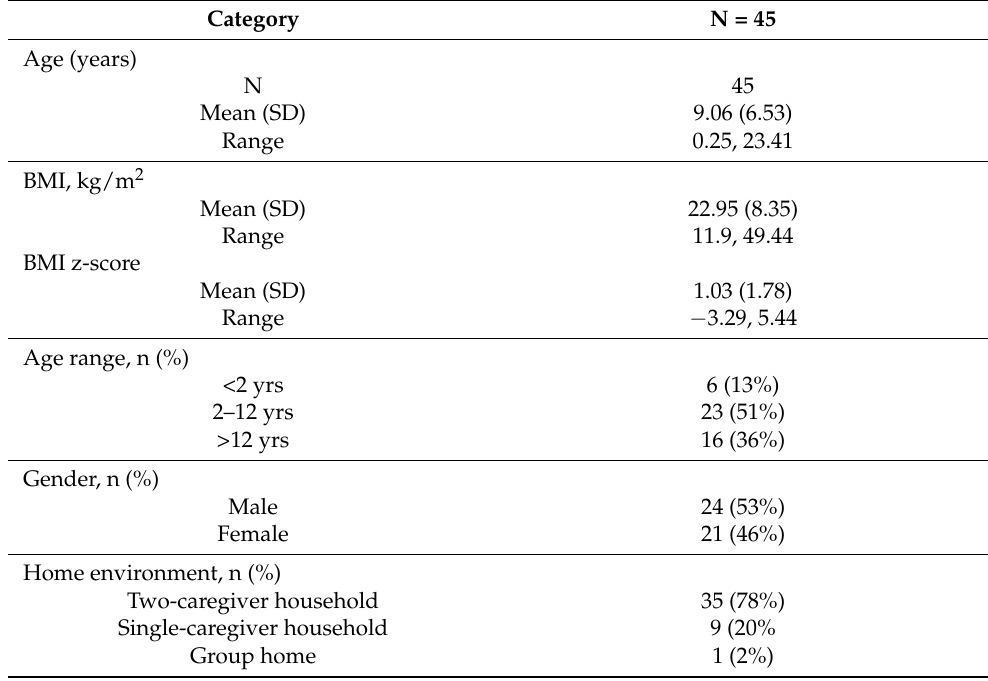
Figure 2. Cumulative PWS caregivers who received choking prevention and first aid education as percent of total population. Table 1. Demographic information for PWS individuals cared for by caregivers .